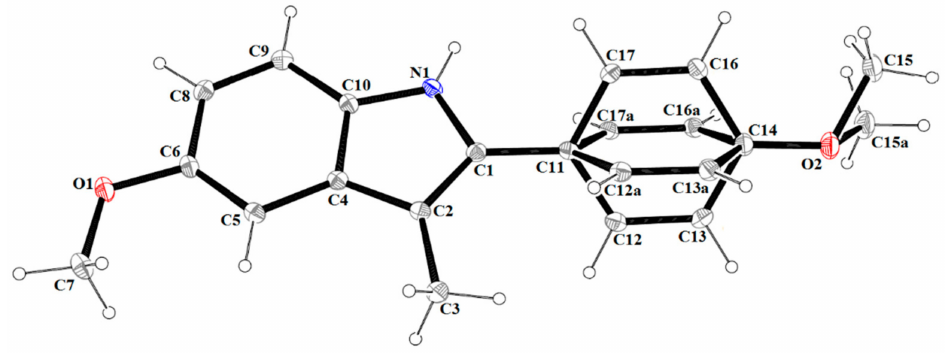
Figure 1. The molecular structure of 1 , with atom labelling. Displacement ellipsoids are drawn at the 30% probability level.